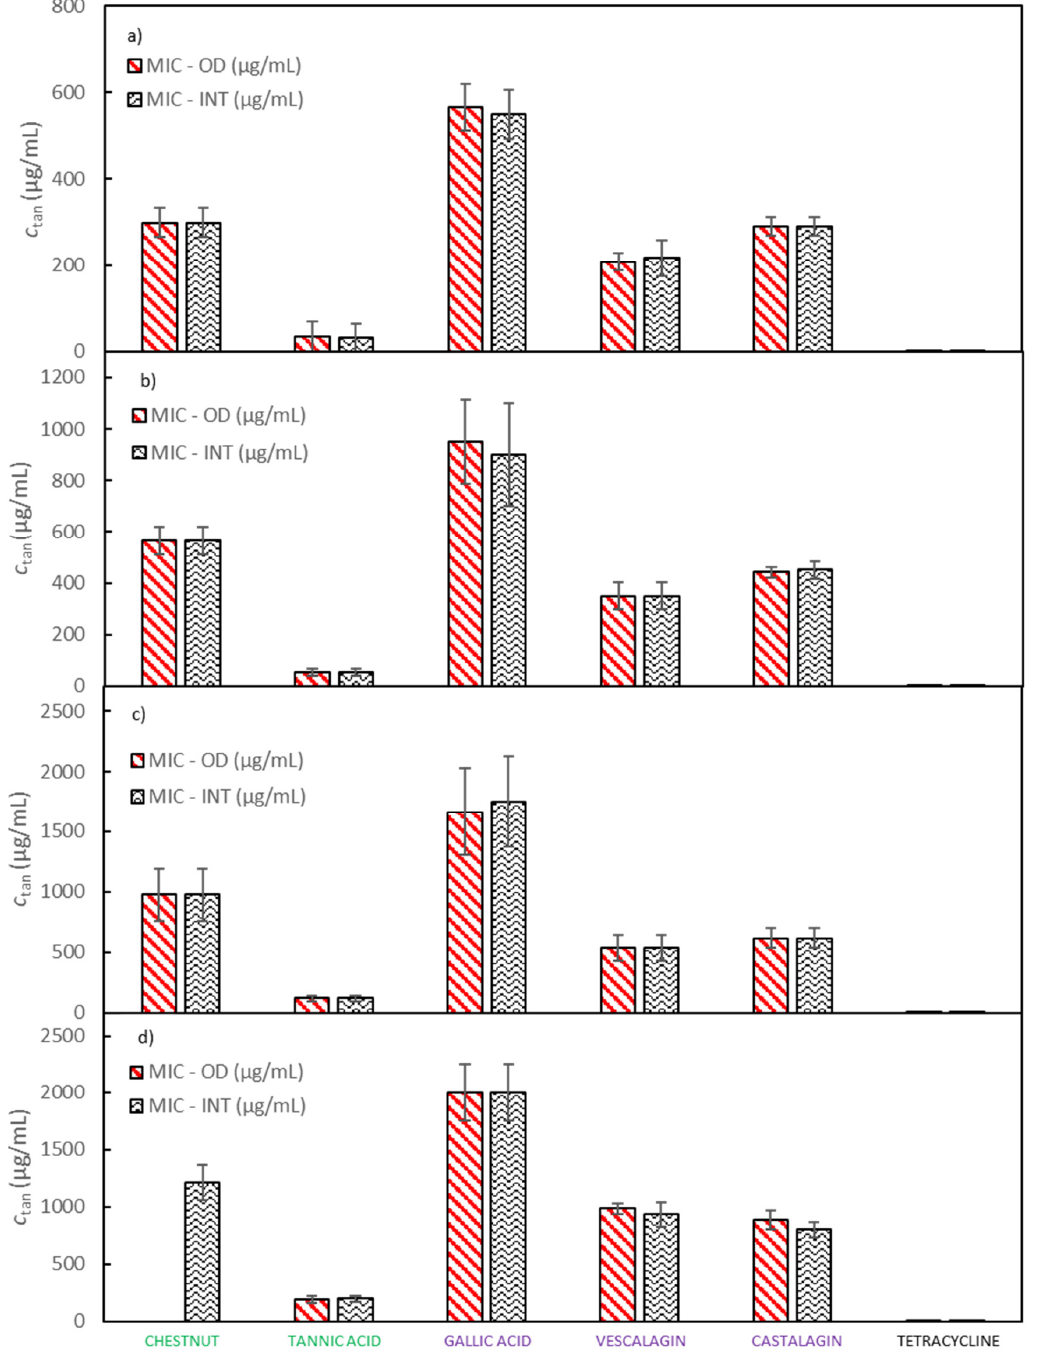
Figure 2. A comparison of MIC values, determined by measurement of the OD and by addition of the INT dye at ( a ) half the concentration of E. coli growth medium recommended by the producer, ( b ) the concentration of E. coli growth medium recommended by the producer, ( c ) one and a half the concentration of E. coli growth medium recommended by the producer and ( d ) double the concentration of E. coli growth medium recommended by the producer. Error bars represent 95% confidence interval.